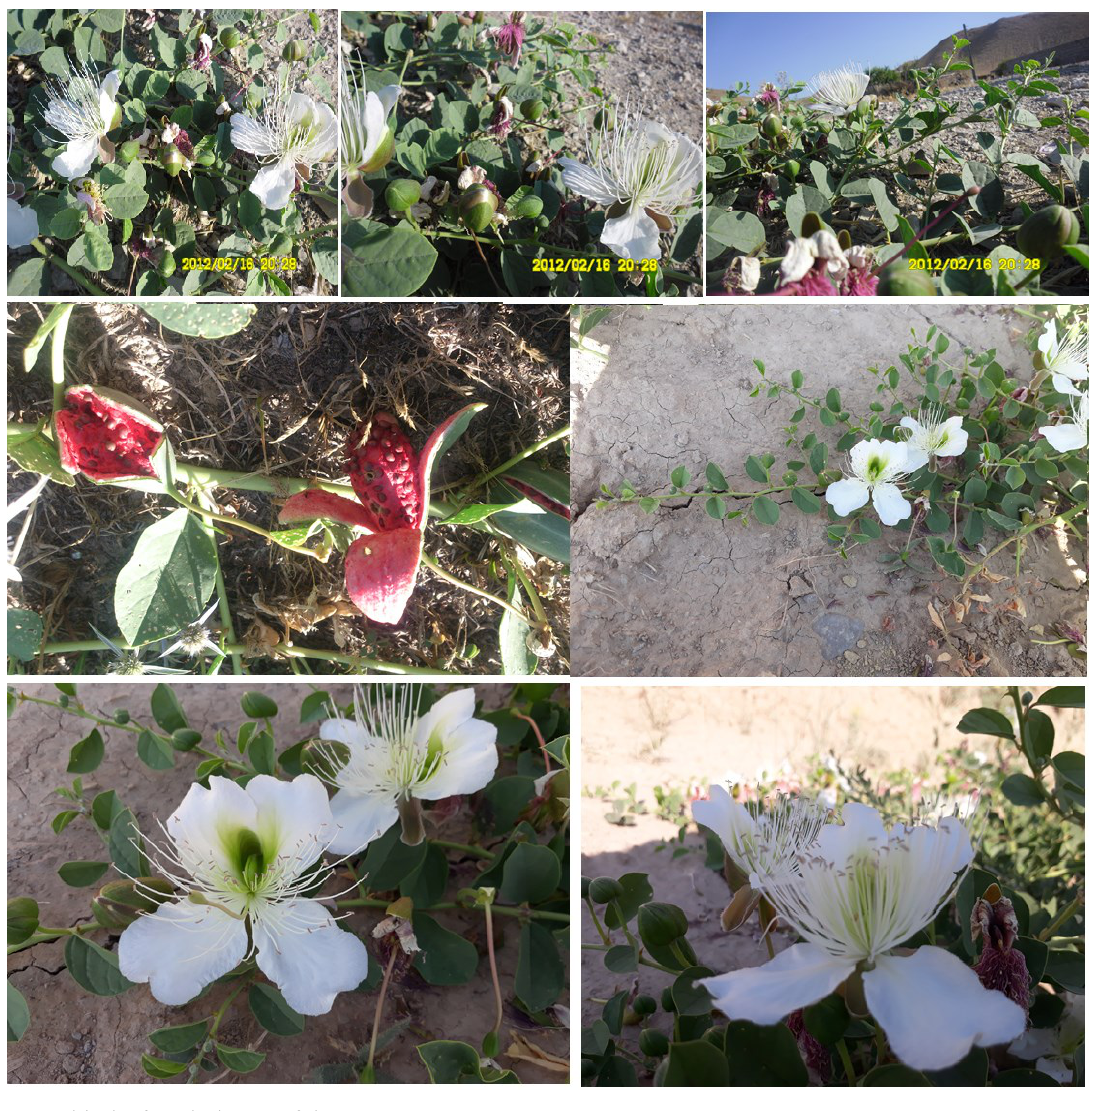
Fig. 2. Habit, leaf, and Flower of the Capparis spinosa . Table 2. List of qualitative characters.